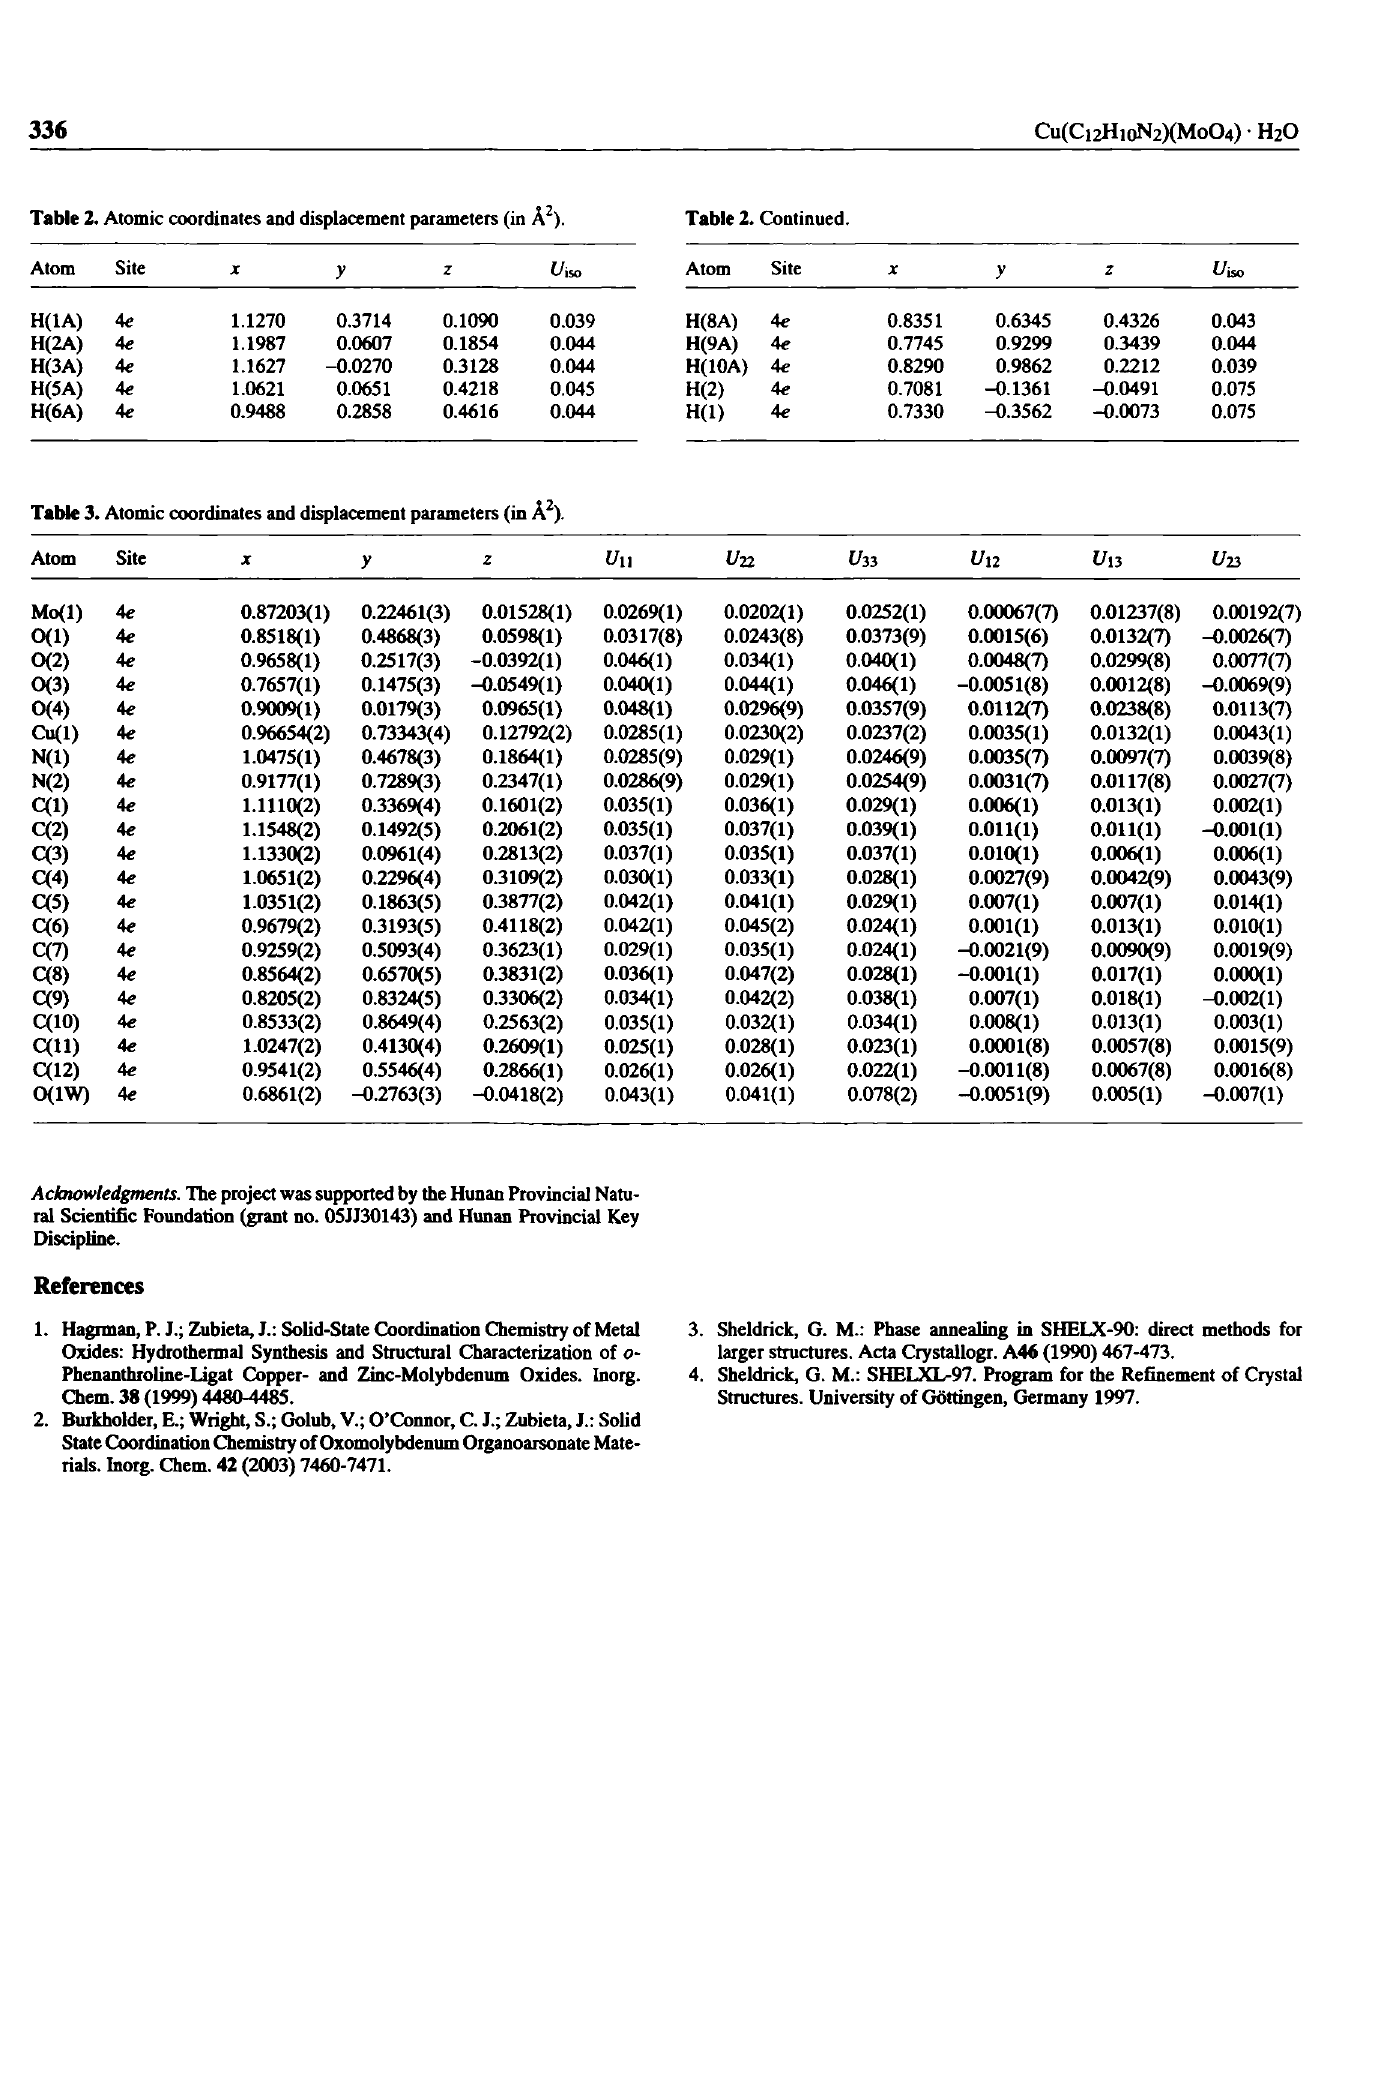
Table 3. Atomic coordinates and displacement parameters (in A 2